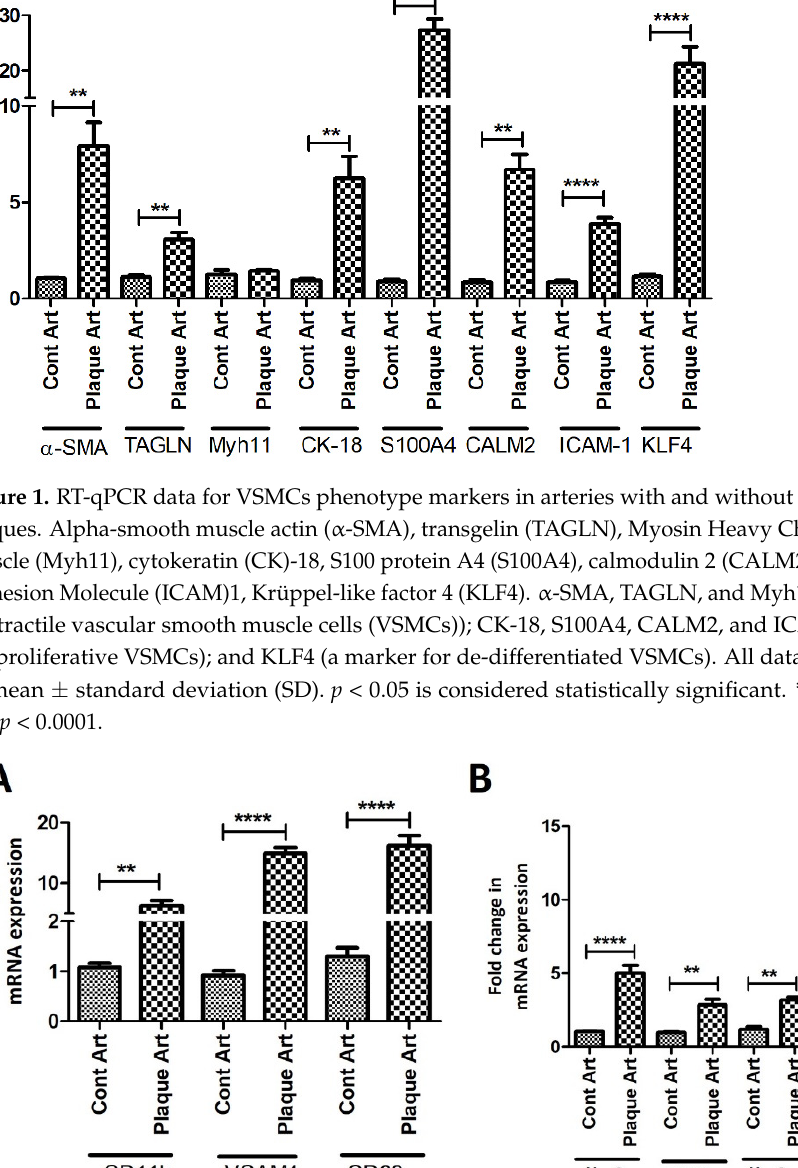
Figure 2. RT ‐ qPCR data for VSMCs phenotype and cytokines in arteries with and without plaque. Panel ( A ) shows qRT ‐ PCR data for CD11b, VCAM1, and CD68, and Panel ( B ) shows qRT ‐ PCR data for cytokines IL ‐ 6, IL ‐ 8, TNF ‐α , and MCP1. Vascular Cell Adhesion Molecule (VCAM)1, interleukin (IL), tumor necrosis factor (TNF) ‐α , CD11b ‐ maker for monocytes, CD68 ‐ marker for macrophages, MCP1 ‐ monocyte chemoattractant protein 1. All data are presented as mean ± standard deviation (SD). p < 0.05 is considered statistically significant. ** p < 0.01 and **** p < 0.0001.